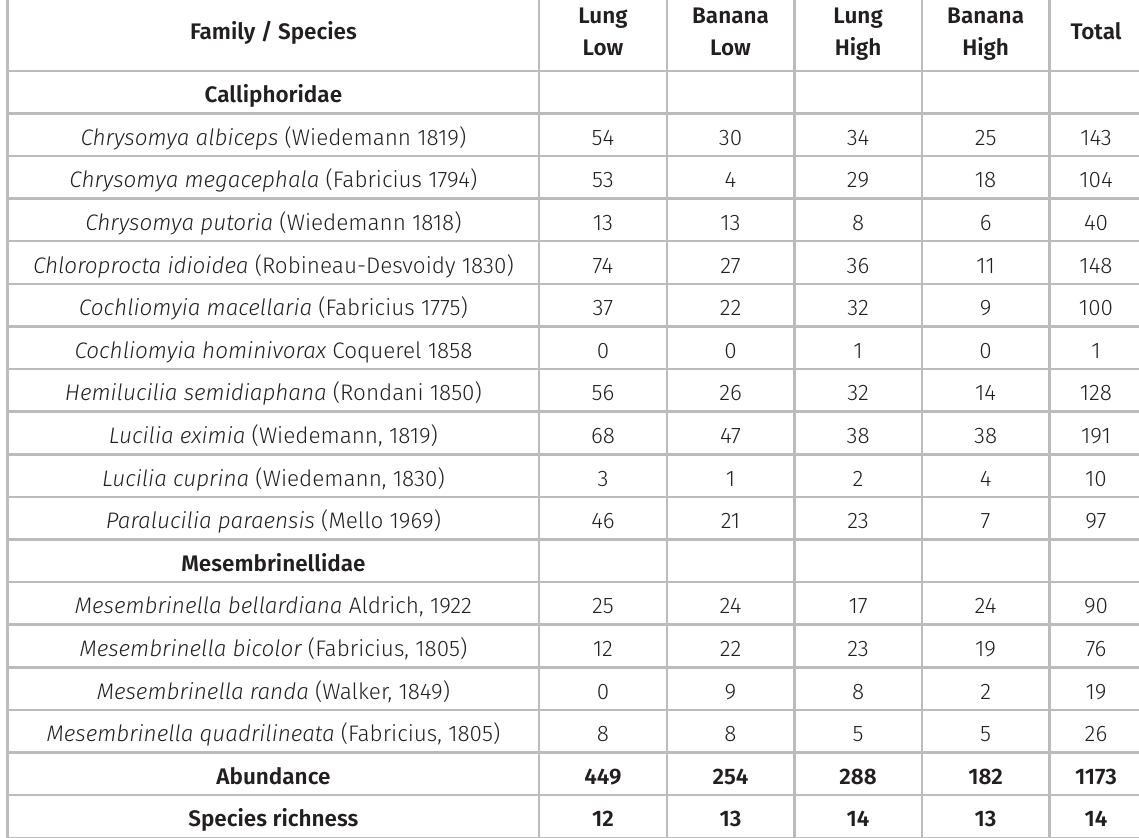
Table I. Species richness and abundance of flies from the Calliphoridae and Mesembrinellidae families collected in two strata (high and low) by using two attractive baits (bovine lung and banana) in the municipality of Mazagão, Amapá State,